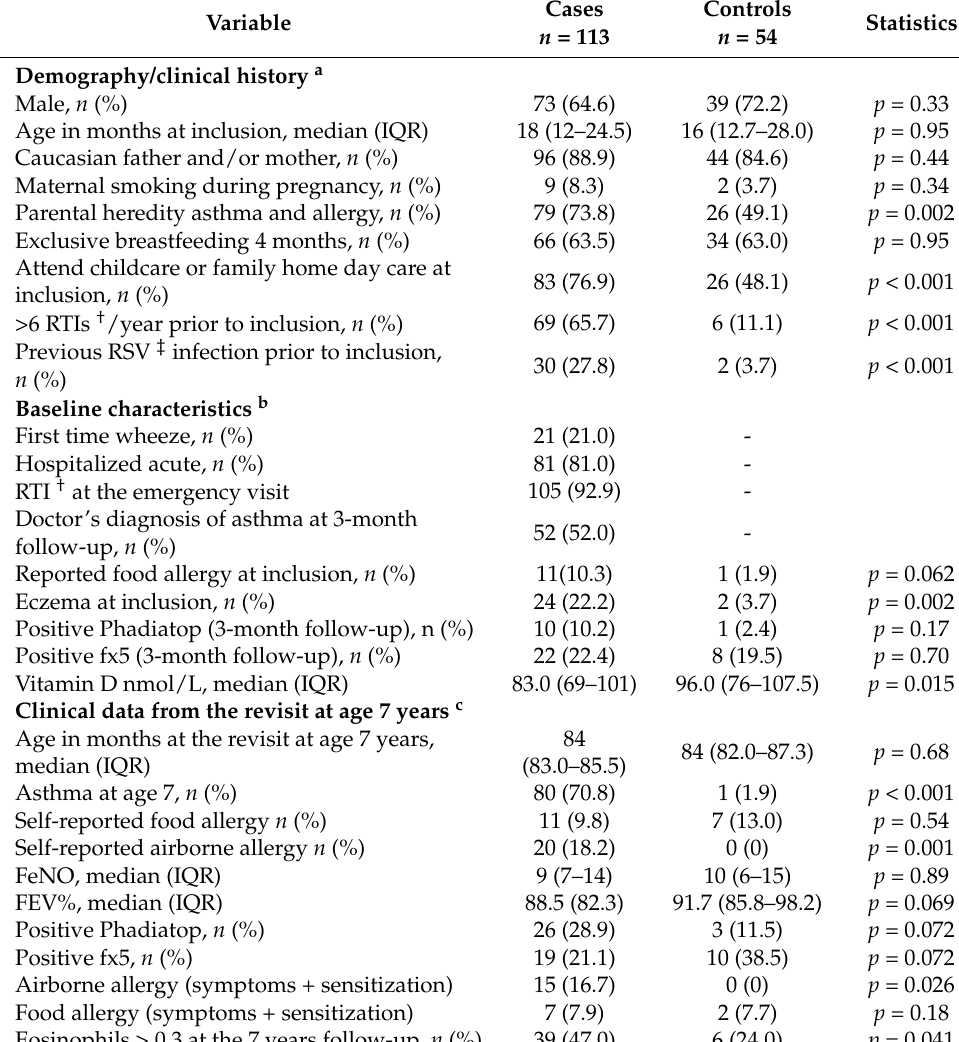
Table 1. Cases vs. control group that attended the revisit at age 7